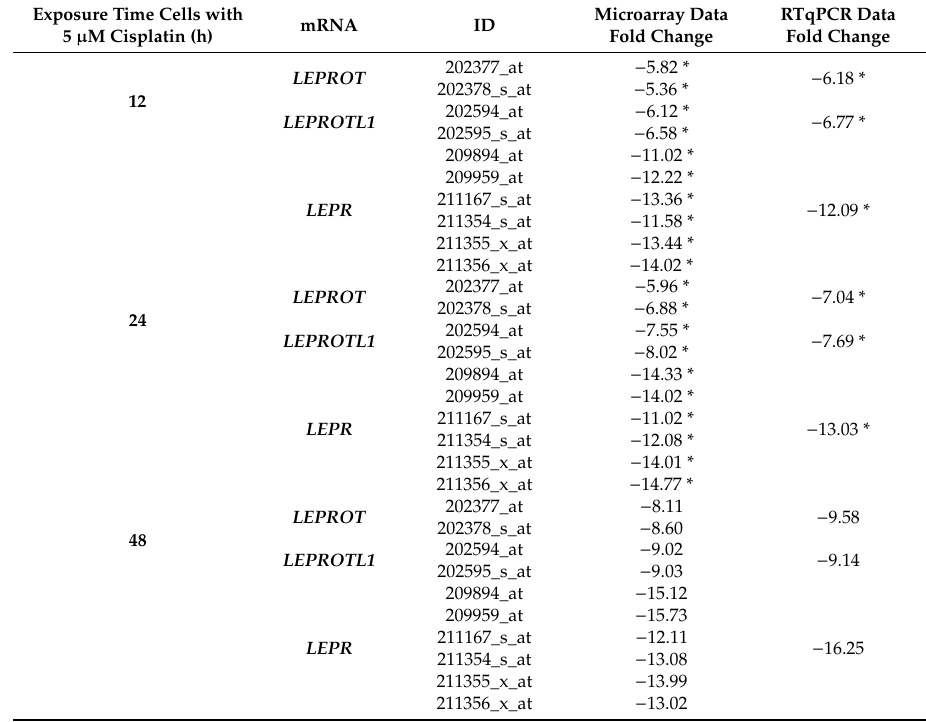
Table 2. Changes in the expression pattern of leptin receptors in the endometrial cancer cell line treated with cisplatin (microarray and RTqPCR). Data presented as a Fold Change (FC) of gene expression in comparison to the control culture ( p <